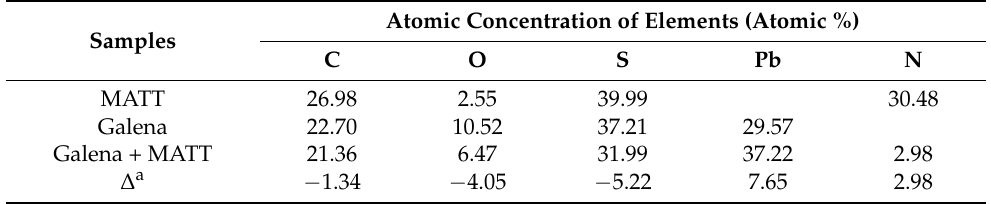
Figure 8. The survey XPS spectra of galena, galena treated with MATT, MATT and MATT treated with Pb 2+ ions.